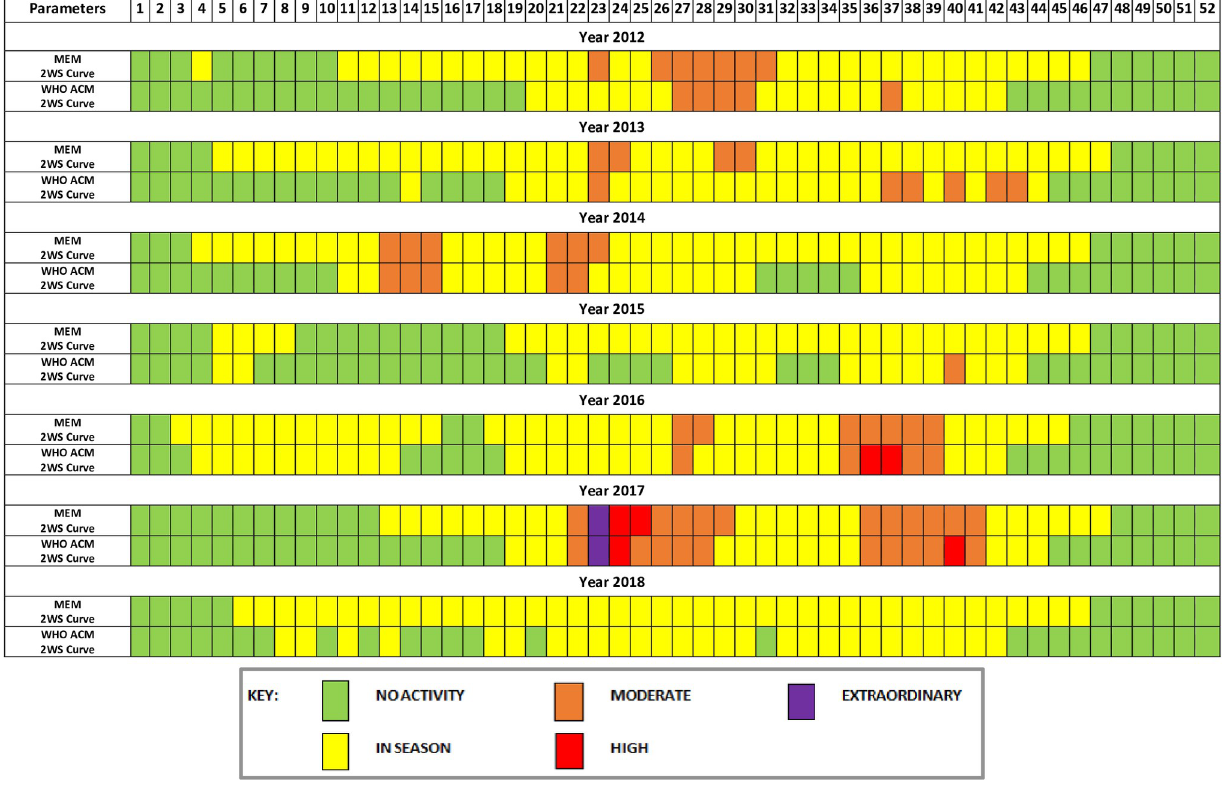
Fig 5. The weekly proportion of attendance for ARI by parameter based on intensity zone of ARI activity of World Health Organization (WHO) method and moving epidemic method (MEM), Mauritius, seasons 2012–2018. https://doi.org/10.1371/journal.pone.0252703.g005 PLOS ONE | https://doi.org/10.1371/journal.pone.0252703 June 3,